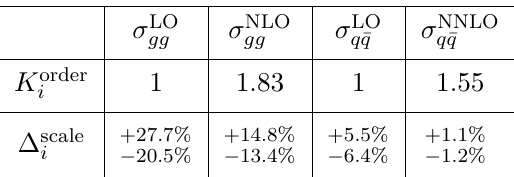
Table 1. QCD K -factors, defined as K order orders in QCD along with the associated relative scale uncertainties ∆ scale